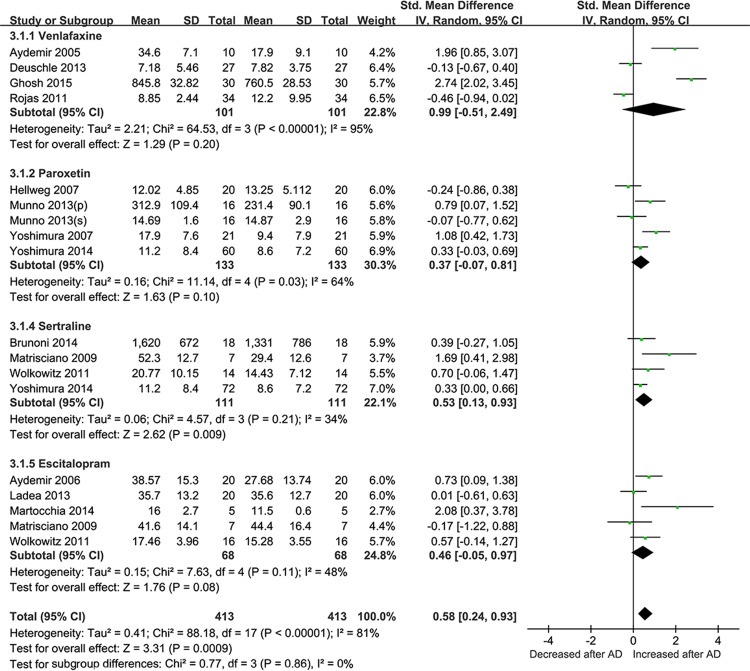
Meta-Analyses for BDNF concentrations at different treatment time points during antidepressants treatment (less than 12 week).Forest plots showing the summary effect sizes for BDNF concentration changes at 4 weeks, 6 weeks, 8 weeks, and 12 weeks.